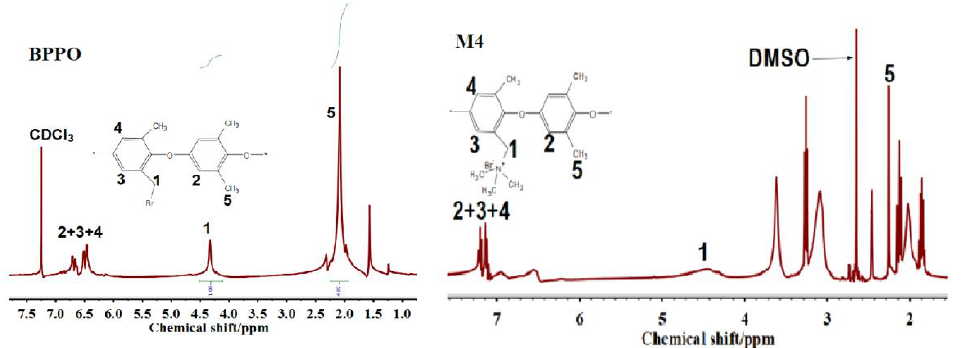
Figure 8. Proton NMR spectrums of BPPO and prepared anion exchange membrane M4.